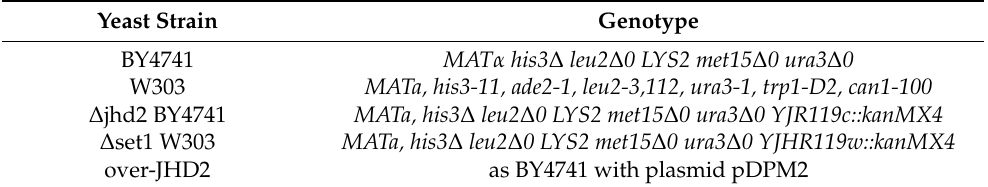
Table 1. Yeast strain used. Yeast